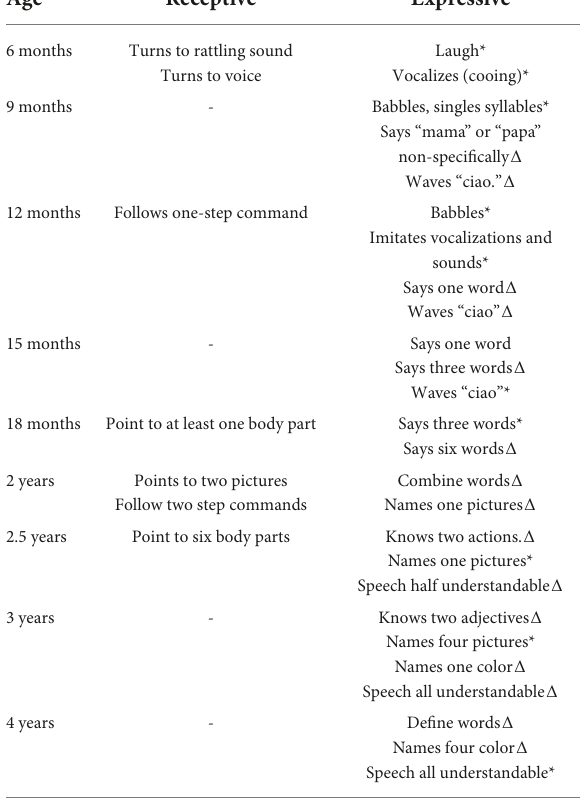
TABLE 2 Developmental milestones for speech and language in